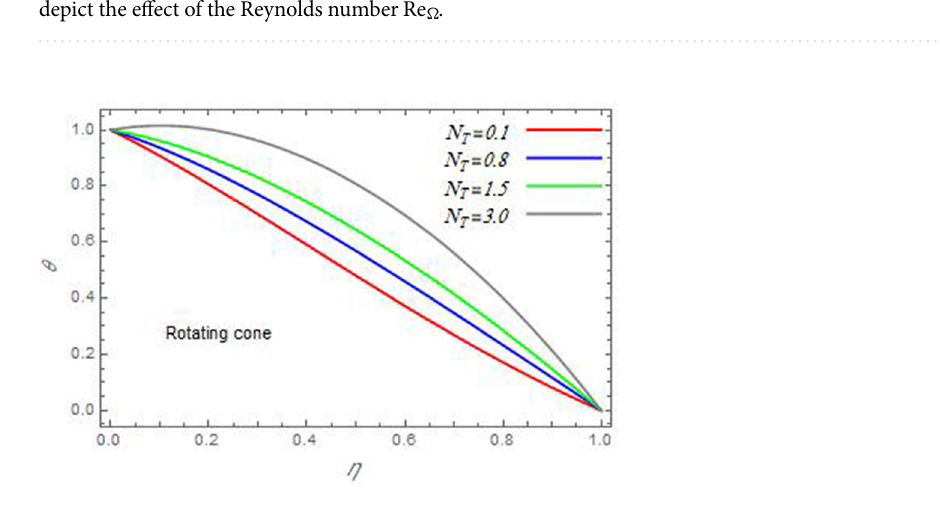
Figure 18. The temperature distribution θ is plotted versus the axial variable η in the case of stationary disc to depict the effect of the thermophoresis parameter N T